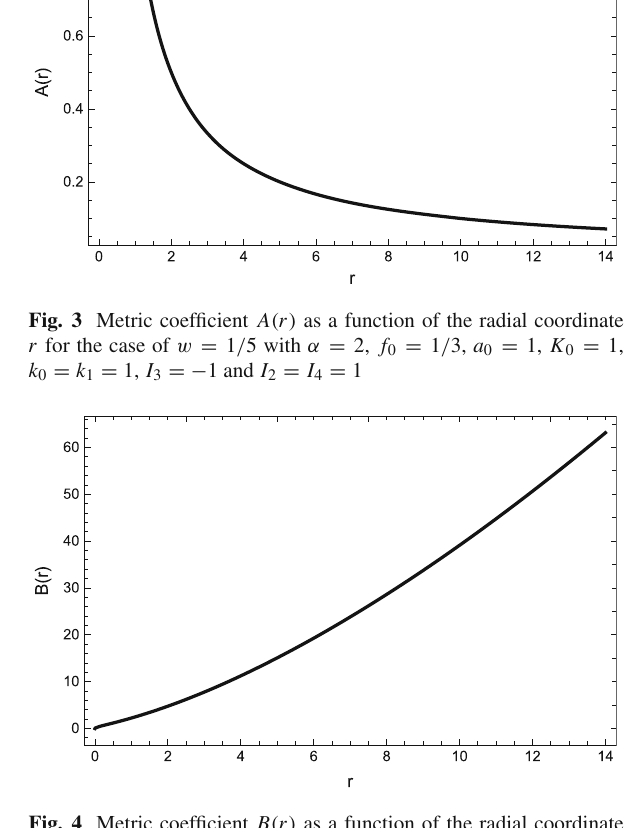
Fig. 4 Metric coefficient B ( r ) as a function of the radial coordinate r for the case of w = 1 / 5 with α = 2, f 0 = 1 / 3, a 0 = 1, K 0 = 1, k 0 = k 1 = 1, I 3 = − 1 and I 2 = I 4 =